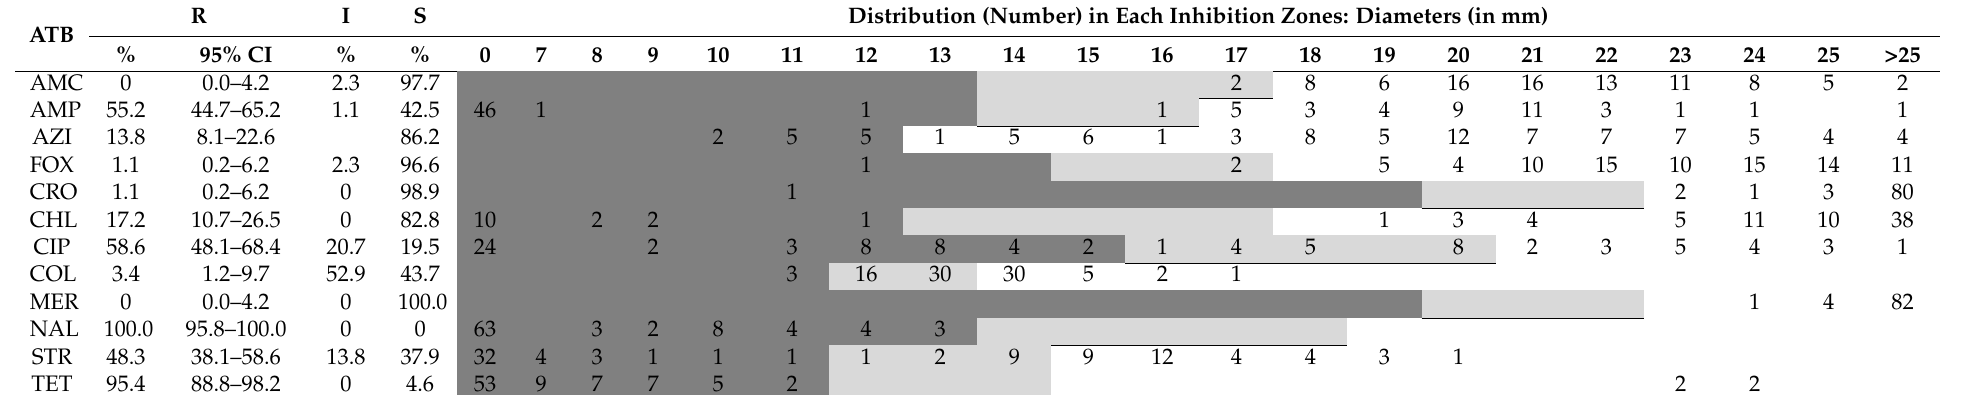
Table 4. Susceptibility to antibiotics of E. coli resistant to quinolones ( n = 87) from food animals in the East province of